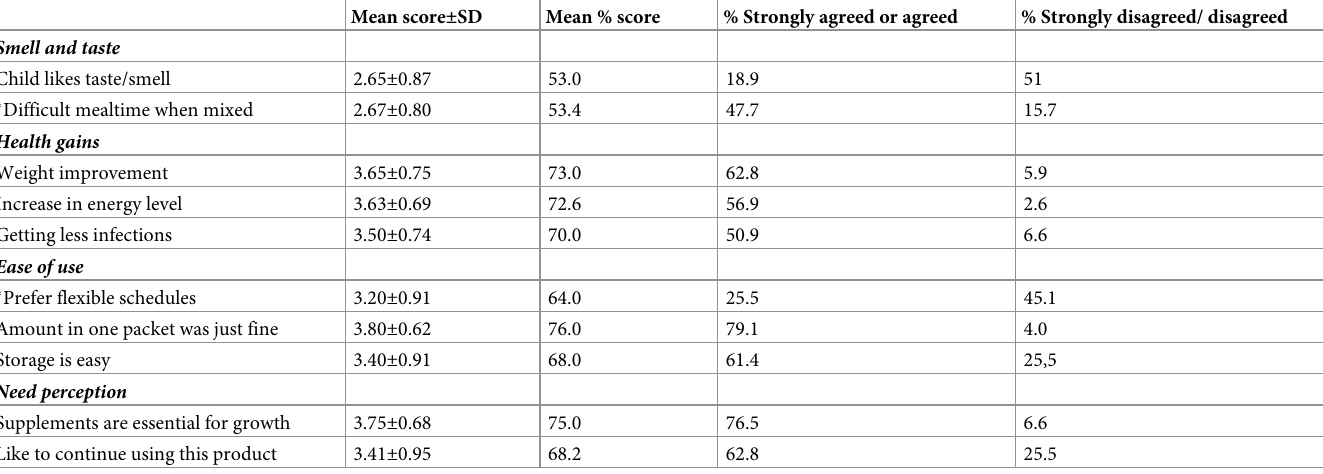
Table 2. Mean acceptability scores and percentage agreed/disagreed with each